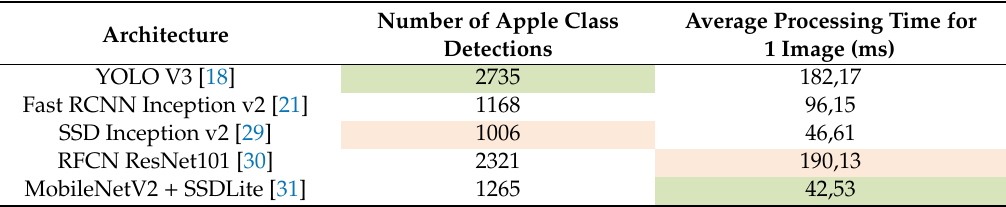
Table 10. Comparison of object detection methods.